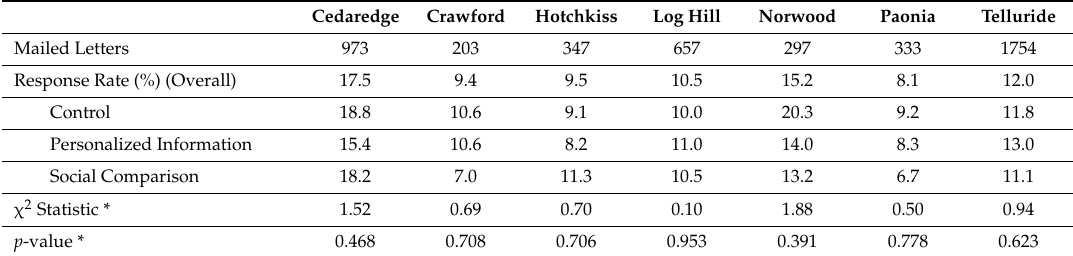
Table 1. Summary of letters mailed and response rates (%) by community and treatment.